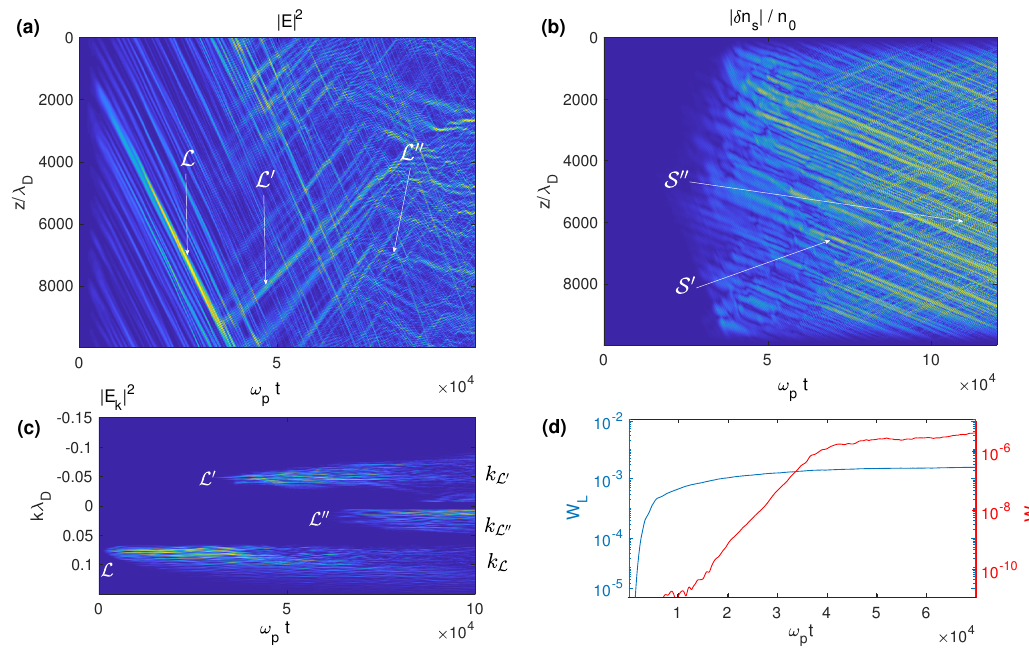
Figure 8. Quasi-homogeneous plasma. ( a ) Space-time variations of the Langmuir energy density | E | 2 . ( b ) Space-time variations of the short-wavelength ion acoustic waves | δ n s | / n 0 . ( c ) Time variation of the Langmuir energy spectrum | E k | 2 . ( d ) Time variations of the energy densities W L and W S of the Langmuir (blue) and ion acoustic (red) waves. Main parameters are the following: ∆ n = 0.001, v b / v T = 14, n b / n 0 = 5 × 10 − 5 , c s / v T = 0.045, γ e , γ i = 0. Examples of Langmuir and ion acoustic wave packets participating to decay processes are indicated by arrows in ( a , b ). All variables are